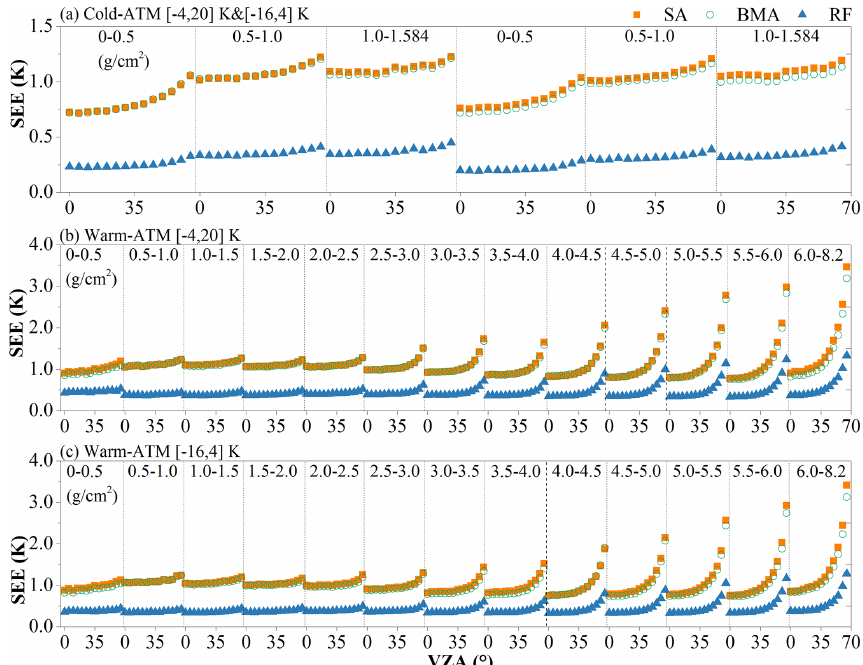
Figure 6. SEE values of the three ensemble methods for NOAA-14 AVHRR under different atmospheric and VZA conditions. (a) Cold-ATM for T s − NSAT within [ − 4, 20]K and [ − 16, 4]K. (b) Warm-ATM for T s − NSAT within [ − 4, 20]K. (c) Warm-ATM for T s − NSAT within [ − 16,